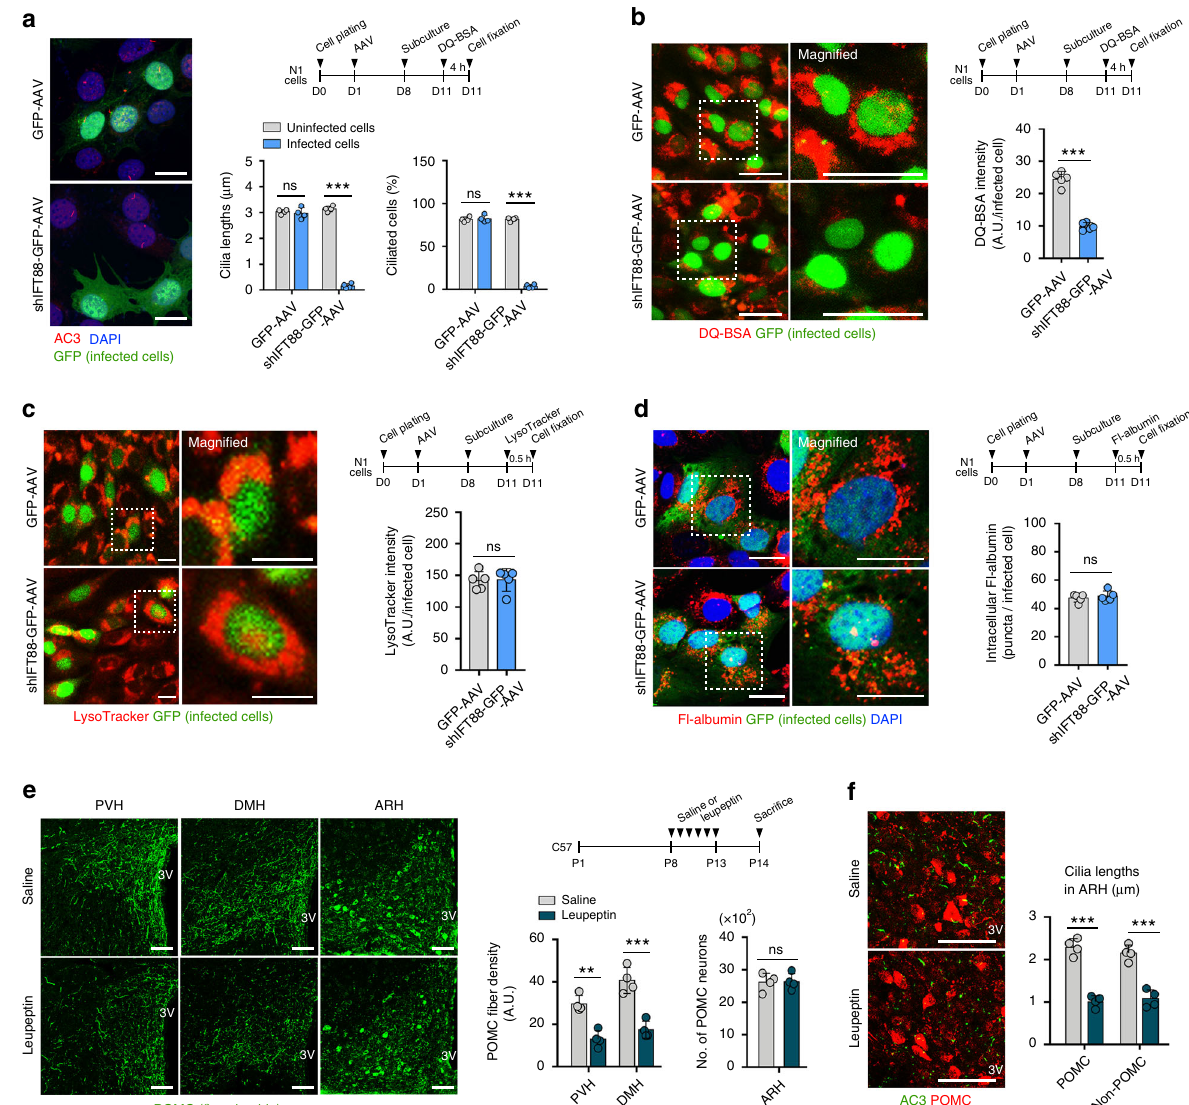
Fig. 7 Interplay among cilia, lysosomal protein degradation, and axonal projection in the hypothalamic neurons. a Con fi rmation of ciliary dysgenesis in N1 hypothalamic neuron cells expressing IFT88 small hairpin RNA (shIFT88)-GFP. ARL13B (cilia marker), GFP, and DAPI staining in N1 cells transfected with shIFT88-GFP-expressing AAV (adeno-associated virus) or GFP-AAV ( n = 4 wells). The average cilia lengths and ciliated cell percentages of about 50 infected cells and 50 uninfected cells are presented in each treatment group. Scale bars: 20 μ m. b DQ-BSA intensity in N1 hypothalamic neuron cells infected with either shIFT88-GFP-AAV or GFP-AAV ( n = 5 wells). The average DQ-BSA intensity of 50 GFP + cells per well was presented. Scale bars: 20 μ m. c Immunostaining of lysosomes using LysoTracker dye in N1 hypothalamic neuron cells ( n = 5 wells). The average values of about 50 infected cells per well are presented. Scale bar: 10 μ m. d Fluorescent-labeled albumin (Fl-albumin), GFP, and DAPI staining in N1 hypothalamic neuron cells transfected with shIFT88-GFP-AAV or GFP-AAV ( n = 5 wells). The average numbers of Fl-albumin + puncta in 50 GFP-expressing cells were measured per well. Scale bars: 20 μ m. e β -END immunostaining in the hypothalamus of C57 neonates injected with saline or leupeptin during P8 – P13 ( n = 4). Scale bars: 100 μ m. f POMC ( β -END) and cilia (AC3) double immunostaining in neonates with saline or leupeptin injections ( n = 4). Scale bars: 100 μ m. Data are presented as mean ± SEM. Statistics were performed using two-sided Student ’ s t test ( a – f ). ** p < 0.01 and *** p < 0.001 between groups. ns not signi fi